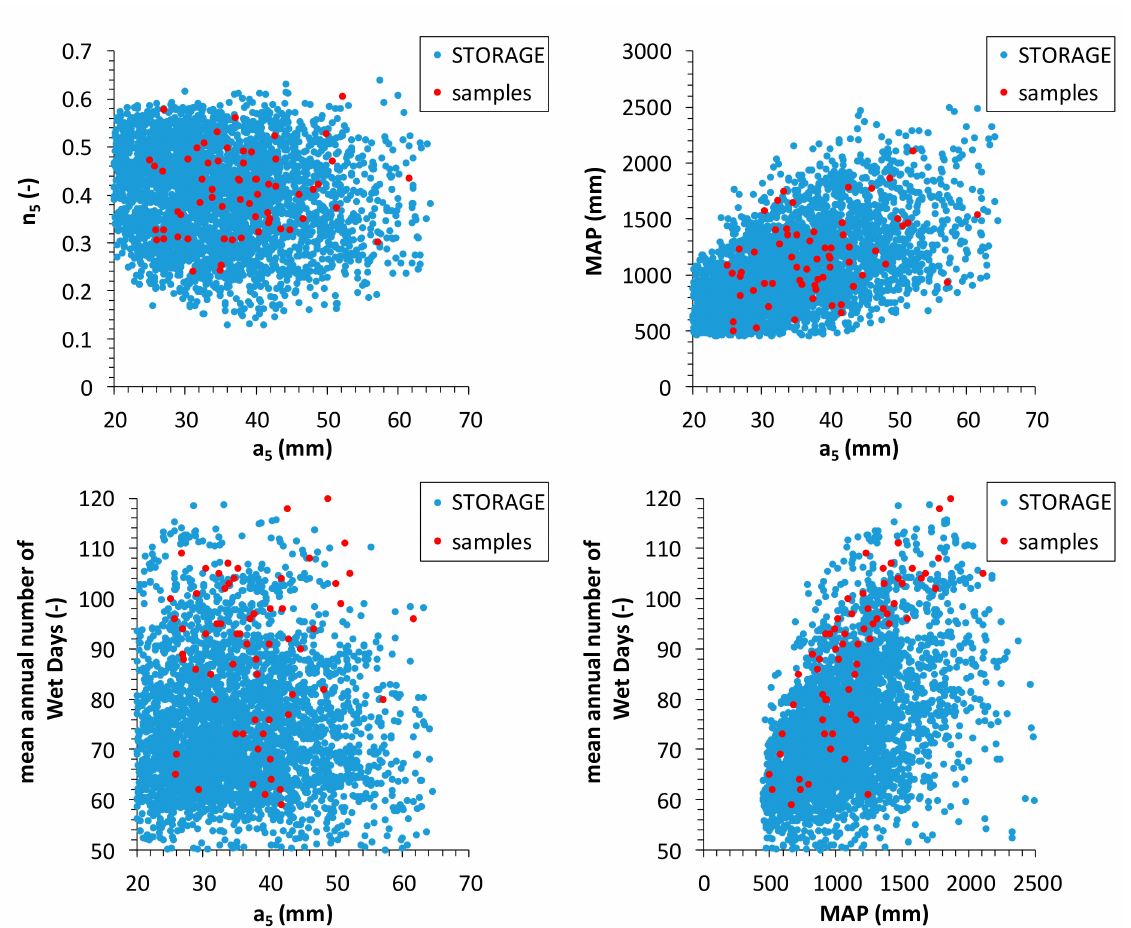
Figure 14. Comparison among synthetic and observed summary